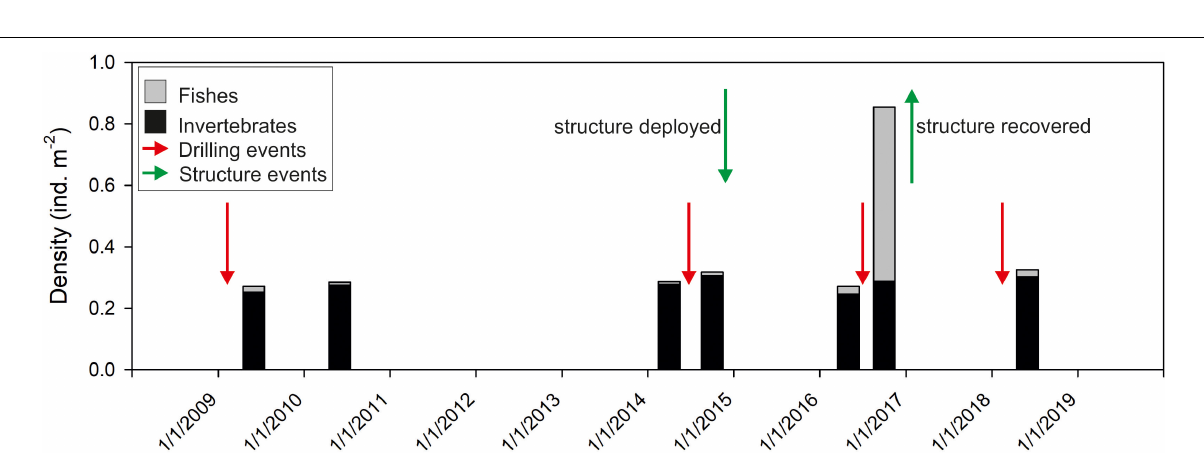
FIGURE 5 | Percentage composition of invertebrate Phyla observed on hard natural substratum at Lancaster and on the Protective Structure A.